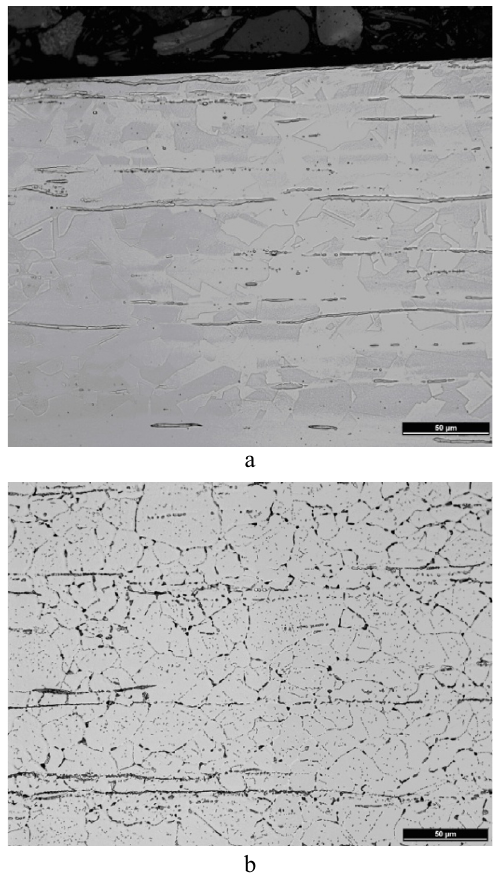
Fig. 7. Microstructure of steel 316 L (the cross-section of the specimen): (a) in as-received state, (b) after exposure in He 750 ° C/1000